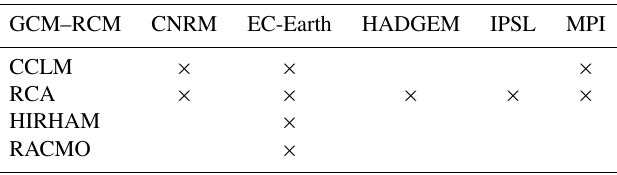
Table A1. GCM–RCM combinations in the EURO-CORDEX ensemble, where the first column indicates the name of the GCM and the first row indicates the name of the